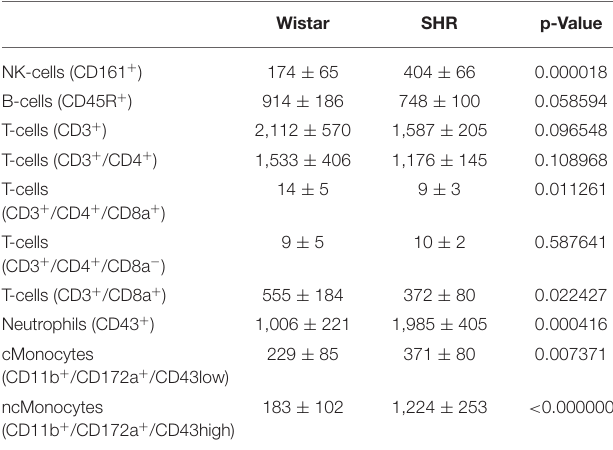
TABLE 1 | Number of circulating blood cells per µ l in 10 months old female